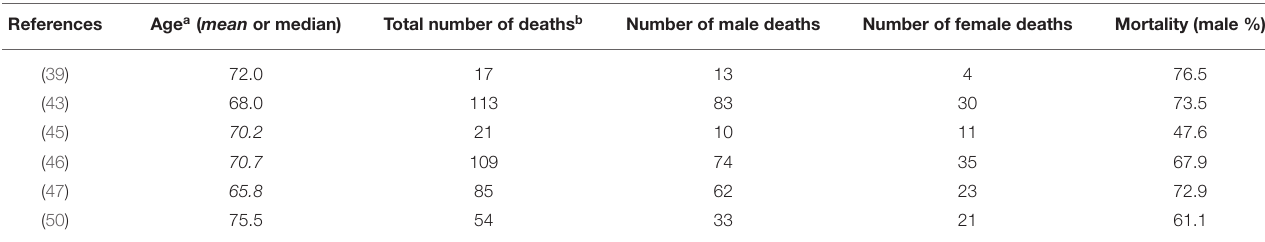
TABLE 6 | All deaths in COVID-19 patients included in the